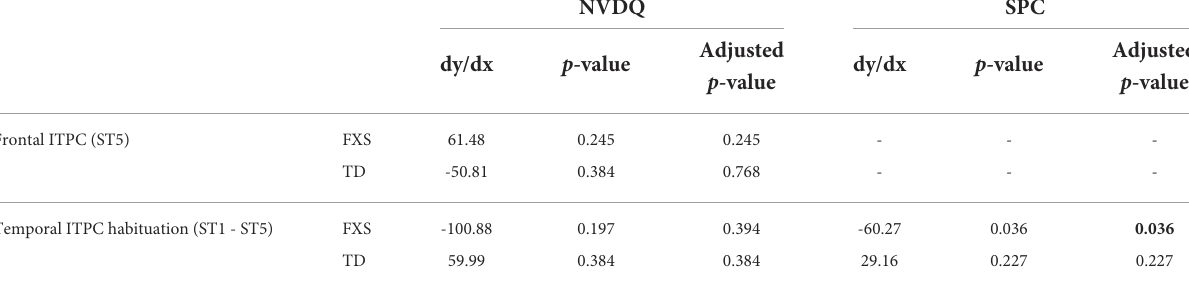
TABLE 5 Marginal effects in Model 1 for the association between EEG and non-language measures in each group. NVDQ